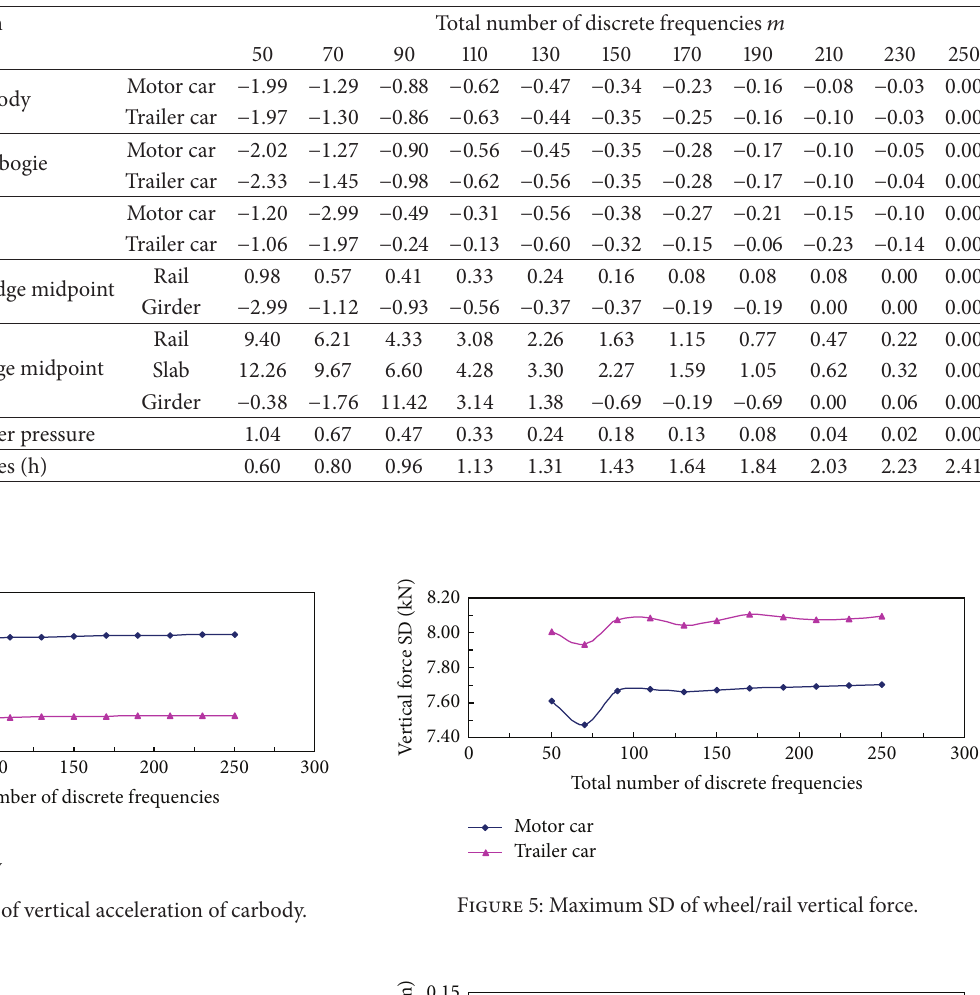
of the responses (%) and CPU times. 1